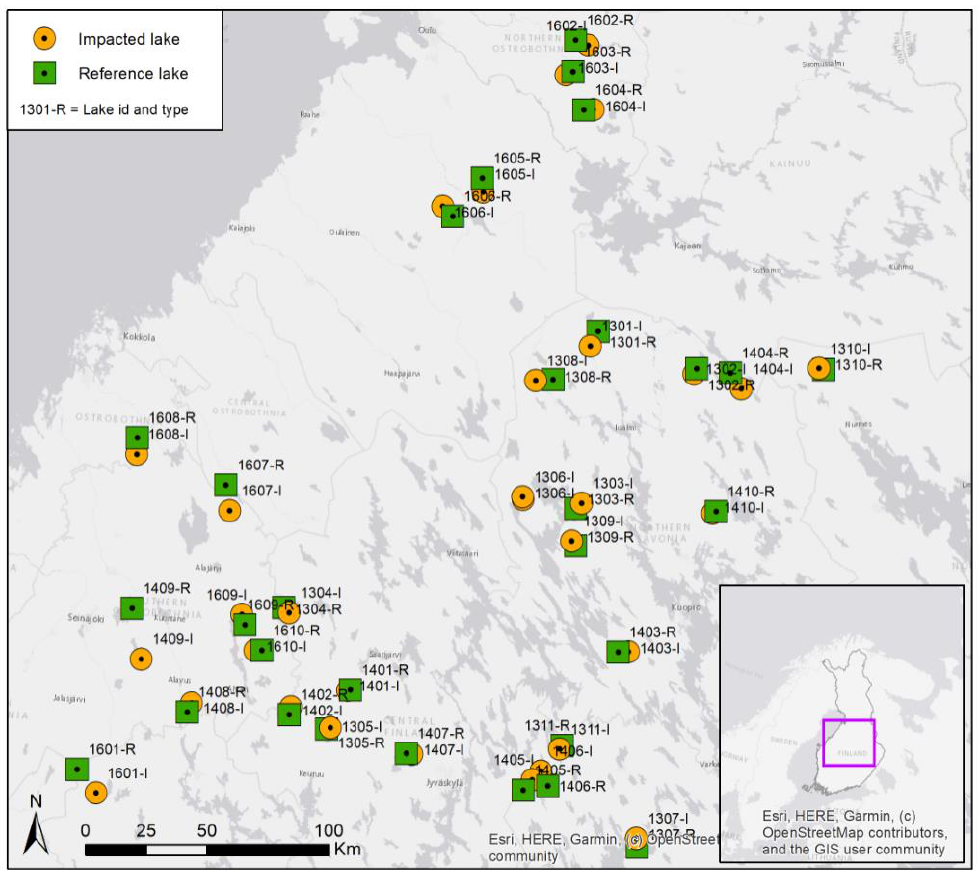
Figure 1. Spatial distribution of the originally selected 62 study lakes.